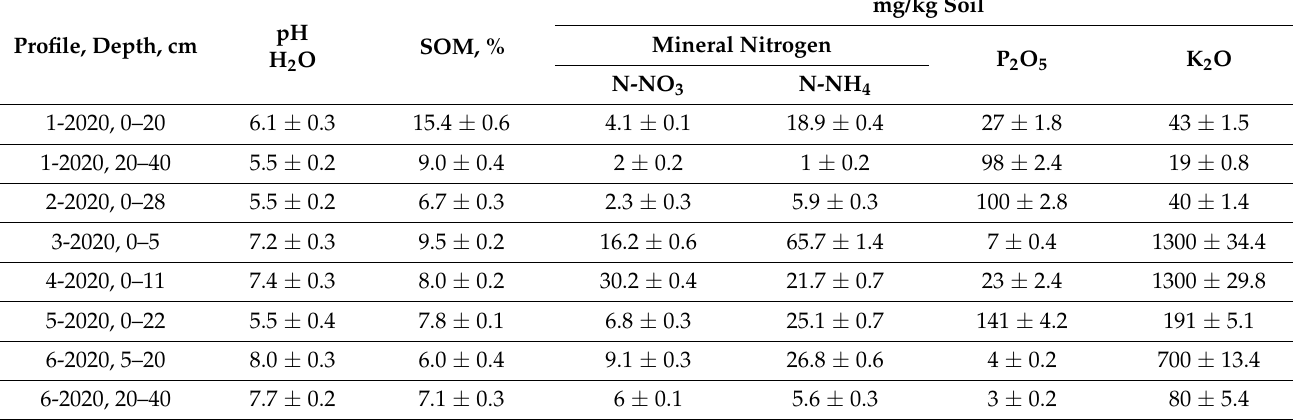
Table 3. Chemical properties of the soils. Values ± SE ( n =